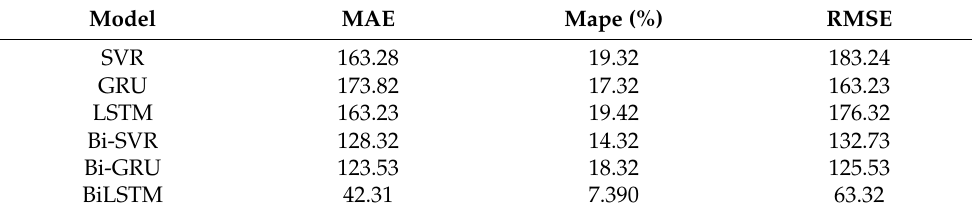
Table 5. Comparison of prediction performances using deep learning